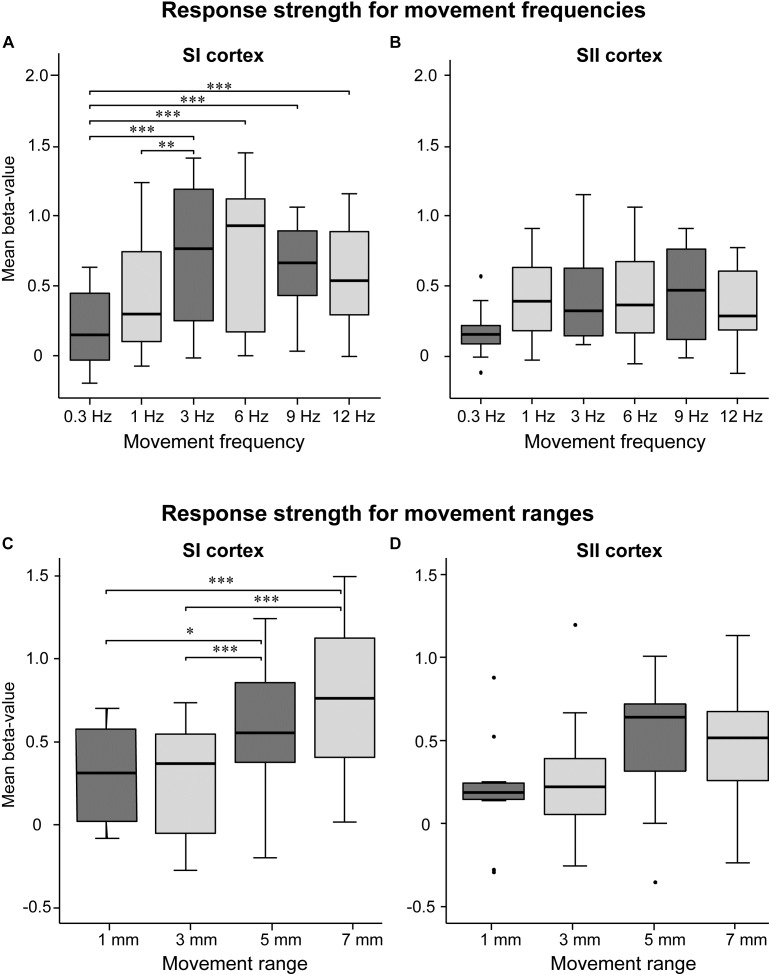
Effect of movement frequency and range. Mean beta-values in the SI (A) and SII (B) cortices for movement frequency (A,B, upper panels) and range (C,D, lower panels; n = 11). The black horizontal line inside the box represent median value. The horizontal boundaries of the boxes represent quartiles. The whiskers indicate the range, excluding outliers that are indicated with black dots. ∗p < 0.05, ∗∗p < 0.01, and ∗∗∗p < 0.001. Please note that the mean beta values between movement frequency and range are not commensurable since they were recorded in separate sessions.